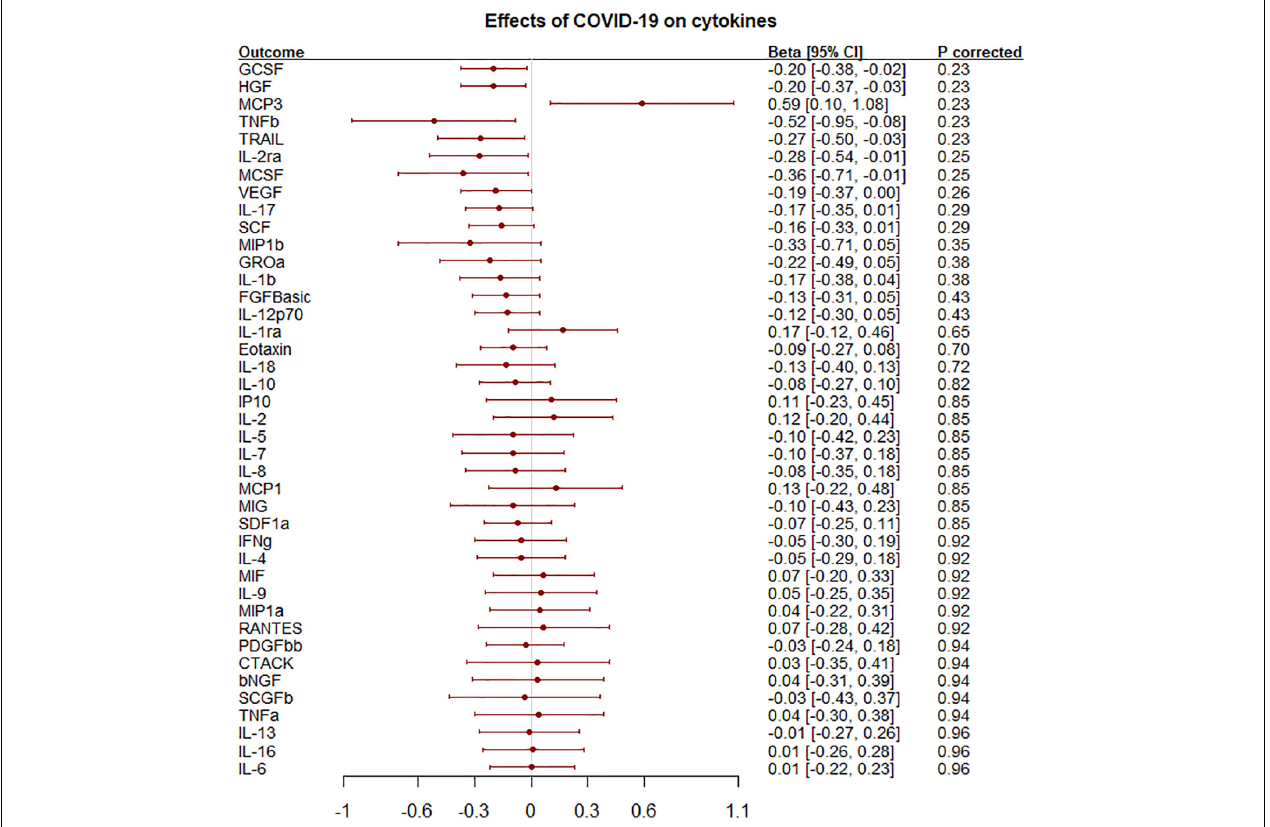
FIGURE 2 | Effects of liability to COVID-19 on 41 circulating cytokines using inverse variance weighting with p- values using a Benjamini-Hochberg